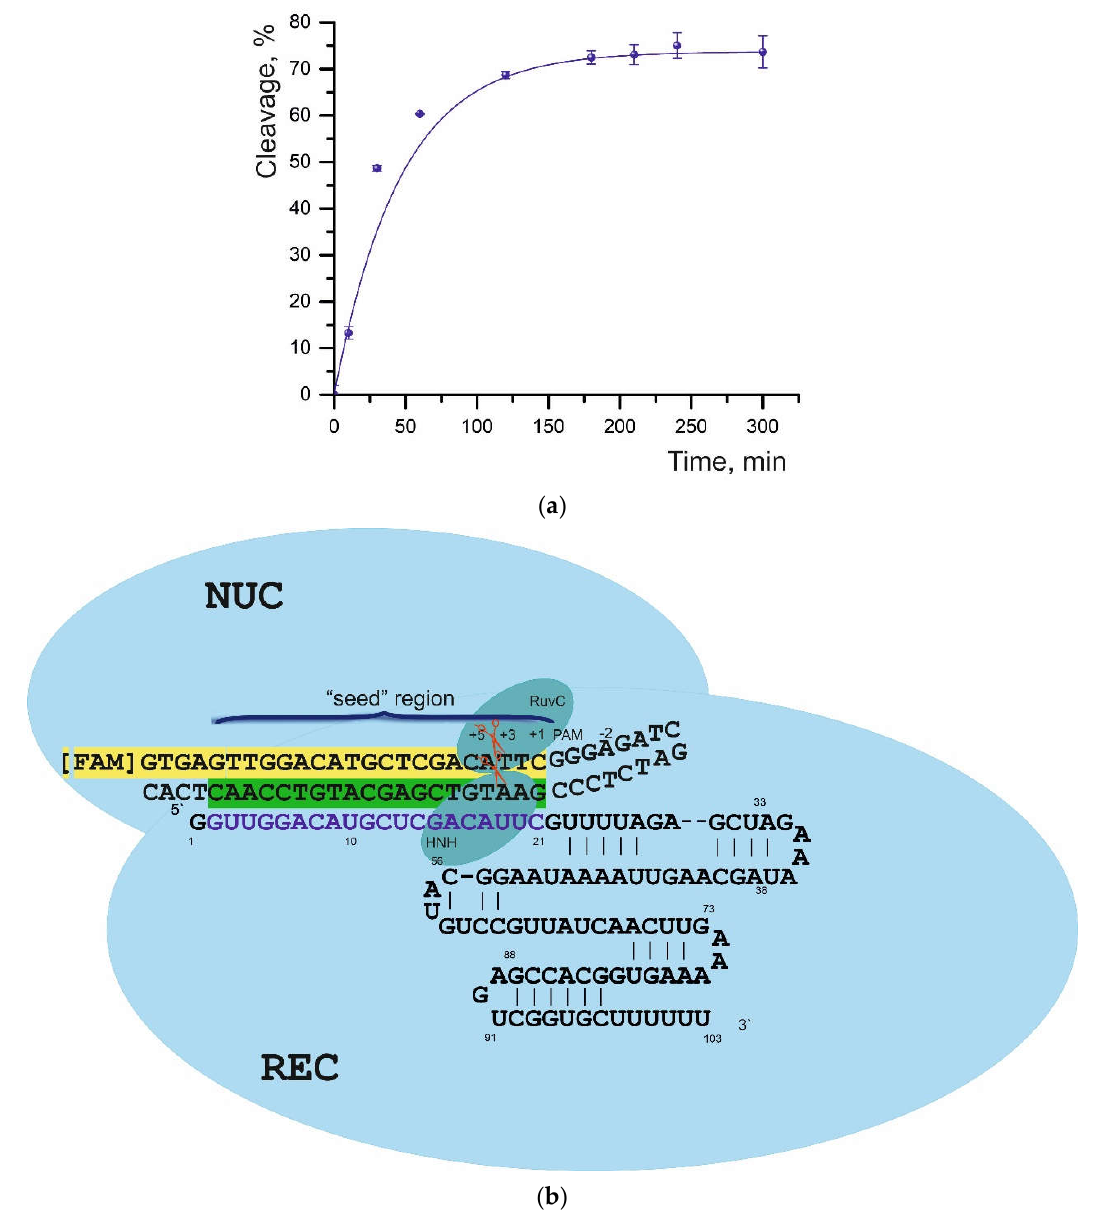
Figure 2. ( a ) The time curve of cleavage of substrate S01. The data were averaged from three independent experiments. The degree (%) of cleavage and error can be found in Table 1. ( b ) Illustration of the complex between Cas9−sgRNA and a DNA substrate. The cleavage site is boldfaced, and sequences forming the complementary duplex are highlighted in green and yellow.